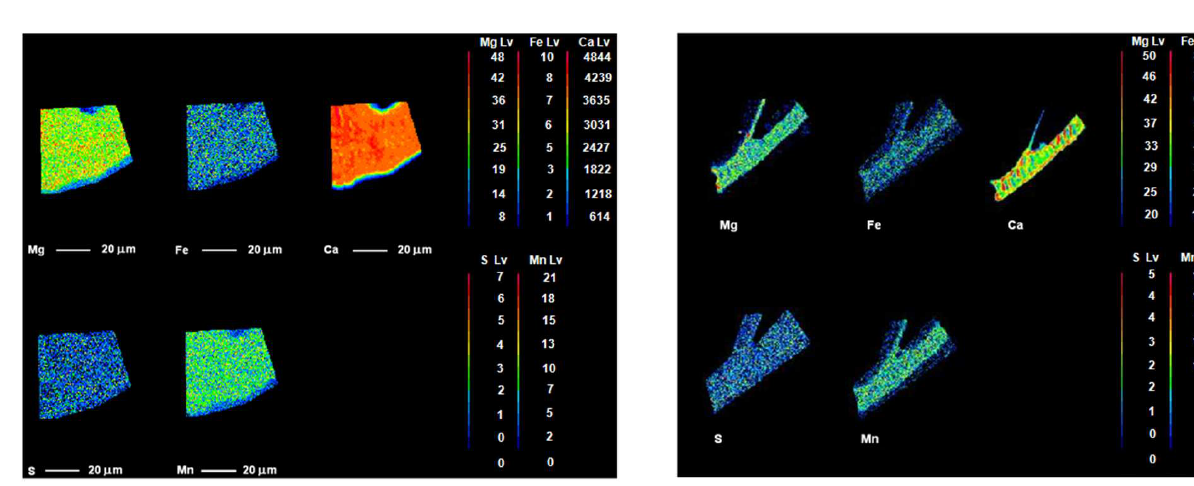
Fig. 6. EMP elemental mapping of a section from a Bolivina spissa from 640m water depth (M77-1-565/MUC-60) on an exposed sec- tion of the foraminiferal test specimen treated with an oxidative cleaning procedure. Distribution of Mg, Fe, Mn, S and Ca in the foraminiferal test. All intensity values are expressed in counts per second (cps) as shown in the color bars. Note that no contaminant phases are visible in the Fe